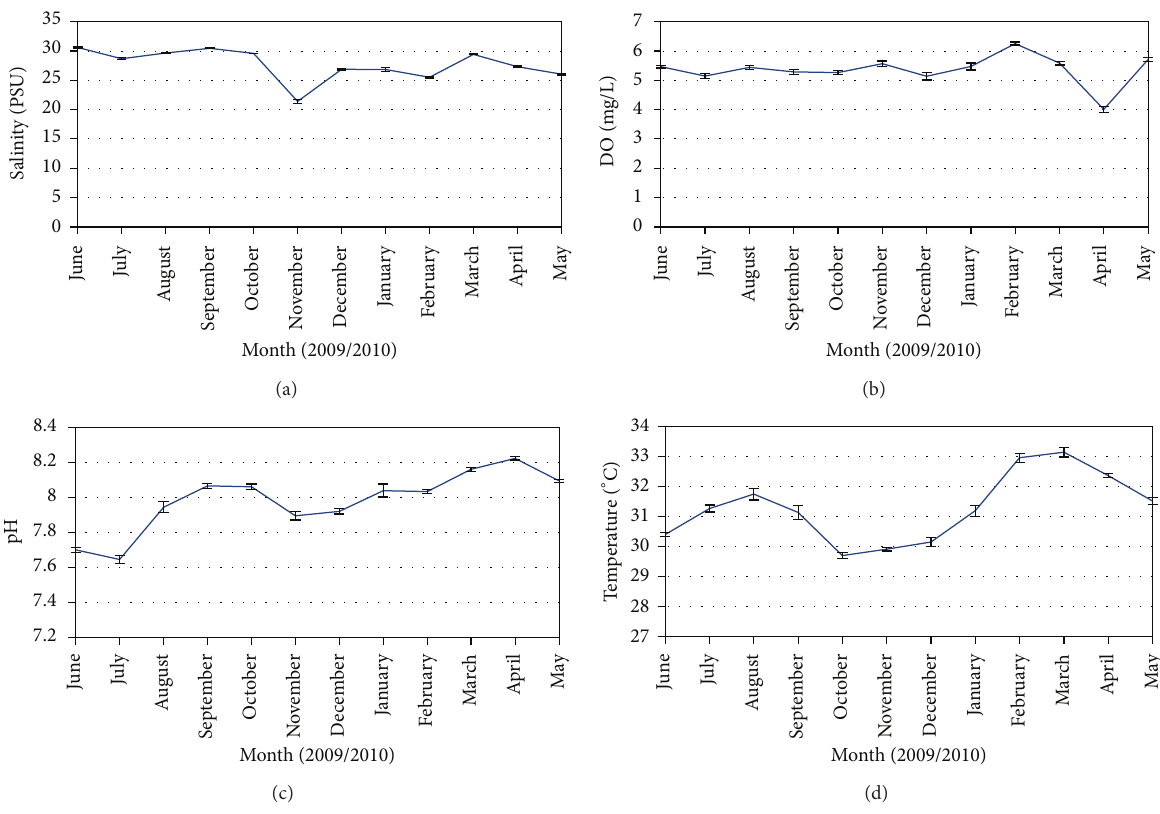
Figure 6: Monthly variations of (a) salinity (PSU) ± S.E, (b) dissolved oxygen (mg/L) ± S.E, (c) pH ± S.E, and (d) temperature ( ∘ C) ± S.E in Lawas.